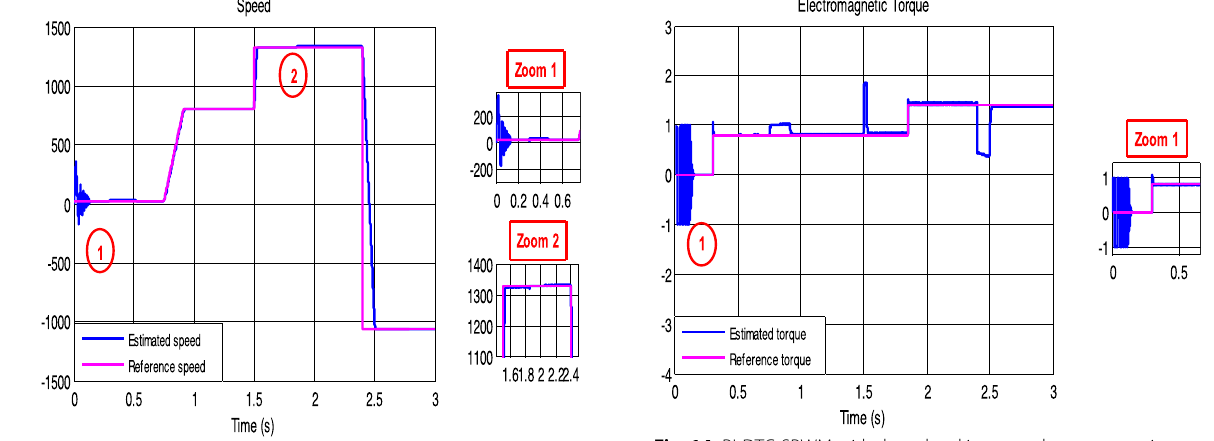
Fig. 12 PI-DTC-SPWM with five-level inverter estimated speed response